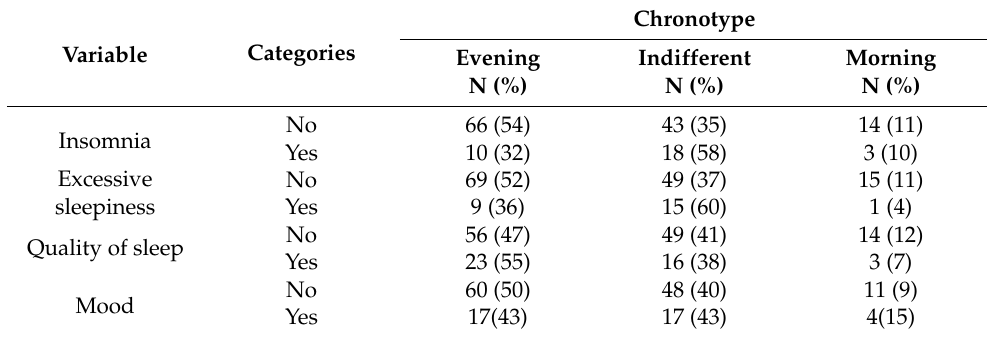
Table 2. Sleep complaints according to PER 3 VNTR